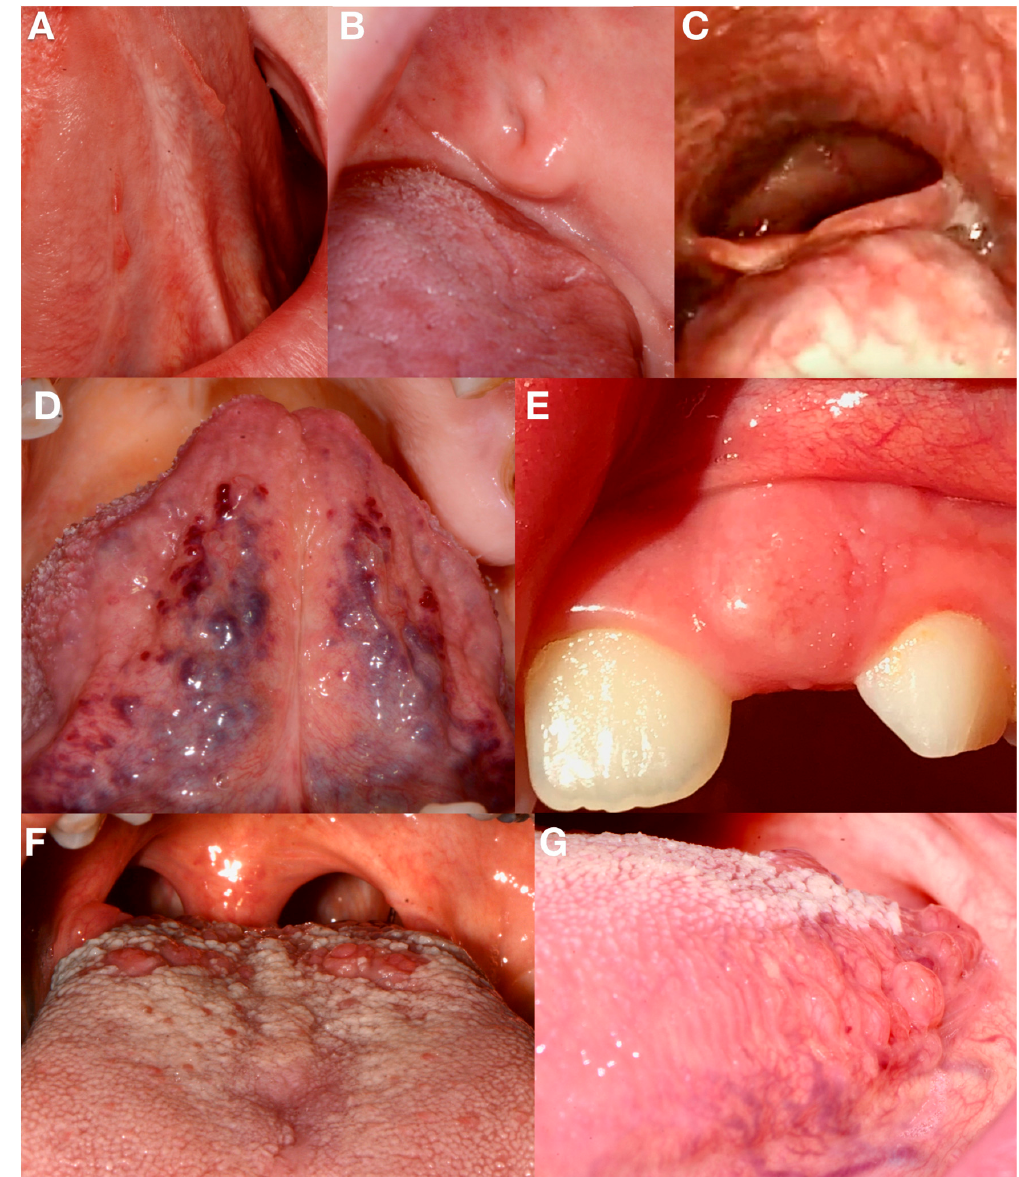
Figure 2. ( A ) Lingual fimbriae; ( B ) Steno’s duct orifice hyperplasia; ( C ) lingual thyroid (endoscopic picture); ( D ) sublingual varices; ( E ) eruptive cyst; ( F ) vallate papillae; ( G ) lingual tonsil.